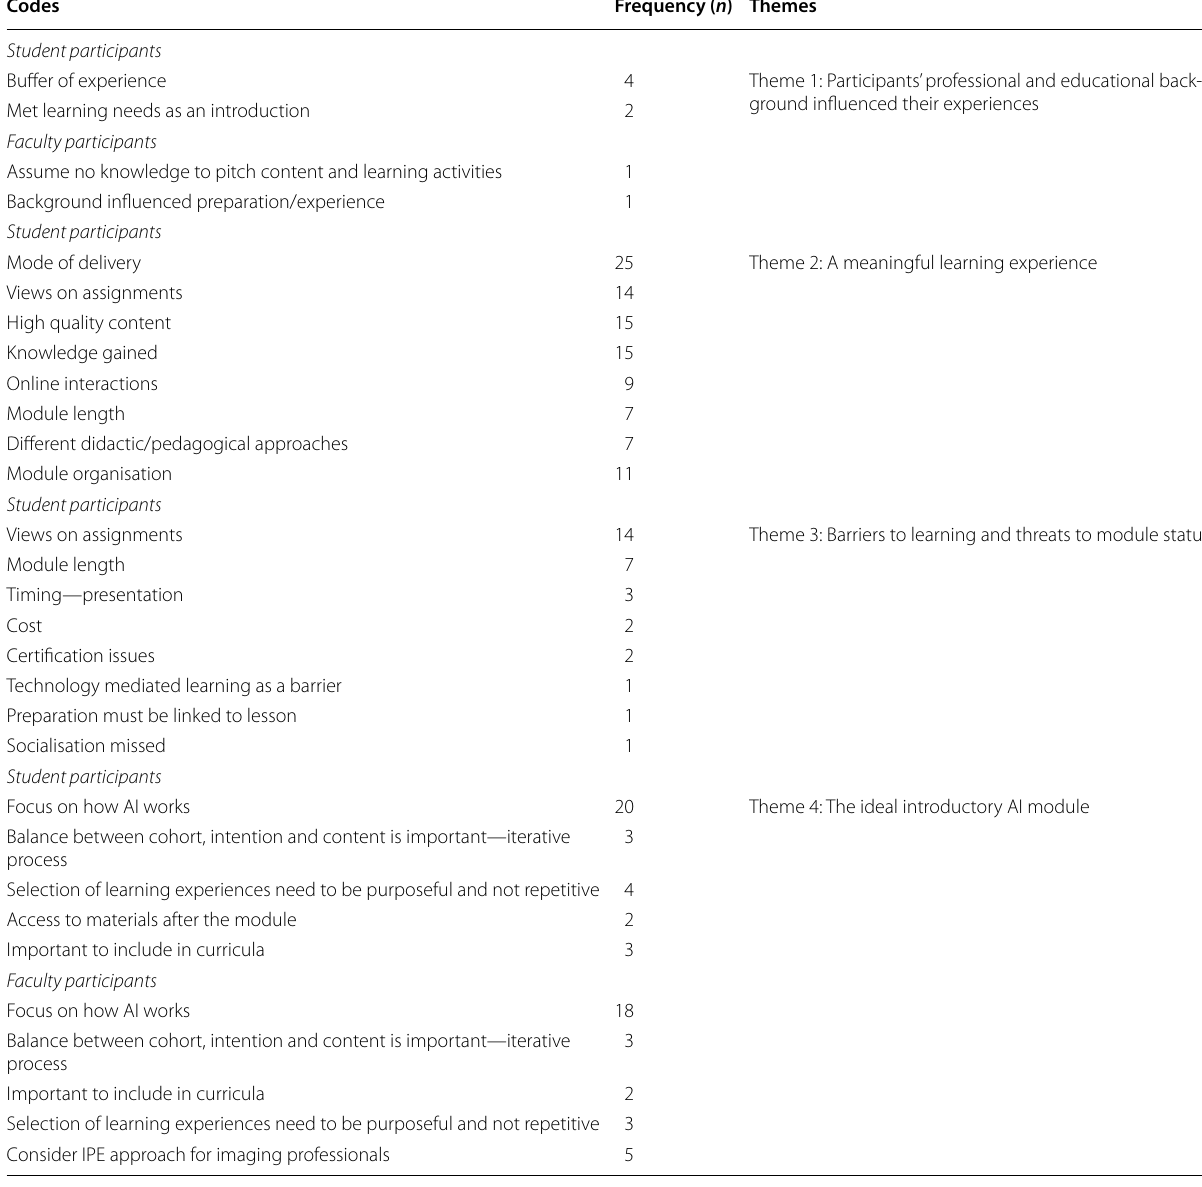
Table 3 Codes, code frequency and convergence of codes to construct the themes